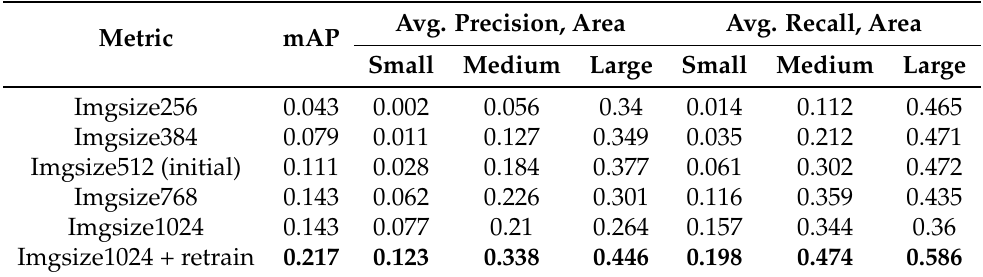
Table 2. The influences of image size on object detection performance. Bold font indicates the best